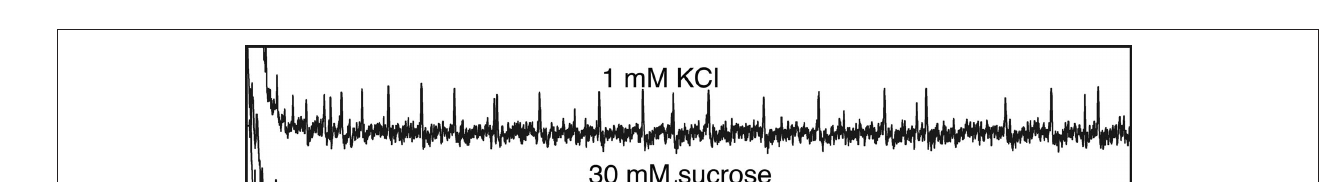
FiGuRe 3 | An example of feeding choice test to behaviorally evaluate taste sensitivity and feeding preference in Drosophila . (A,B) Hungry flies after 20 h of food deprivation ingest a maximum amount of 100 mM sucrose + 1% agar solutions mixed with red or blue food dyes, respectively, and can be visually inspected after feeding. (C) A microtiter dish containing two different solutions containing the two food dyes to test for the feeding preference. (D) A video